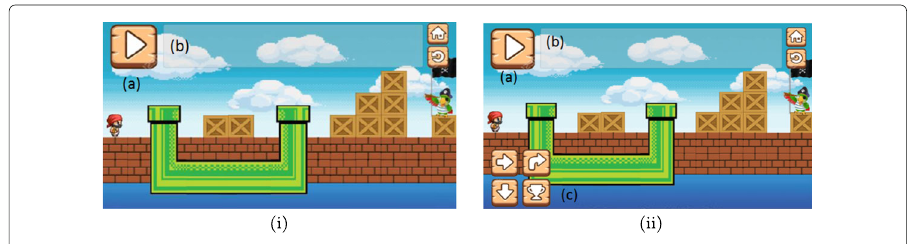
Fig. 1 Blackbeard’s Mission. i Camera version. ii Tablet